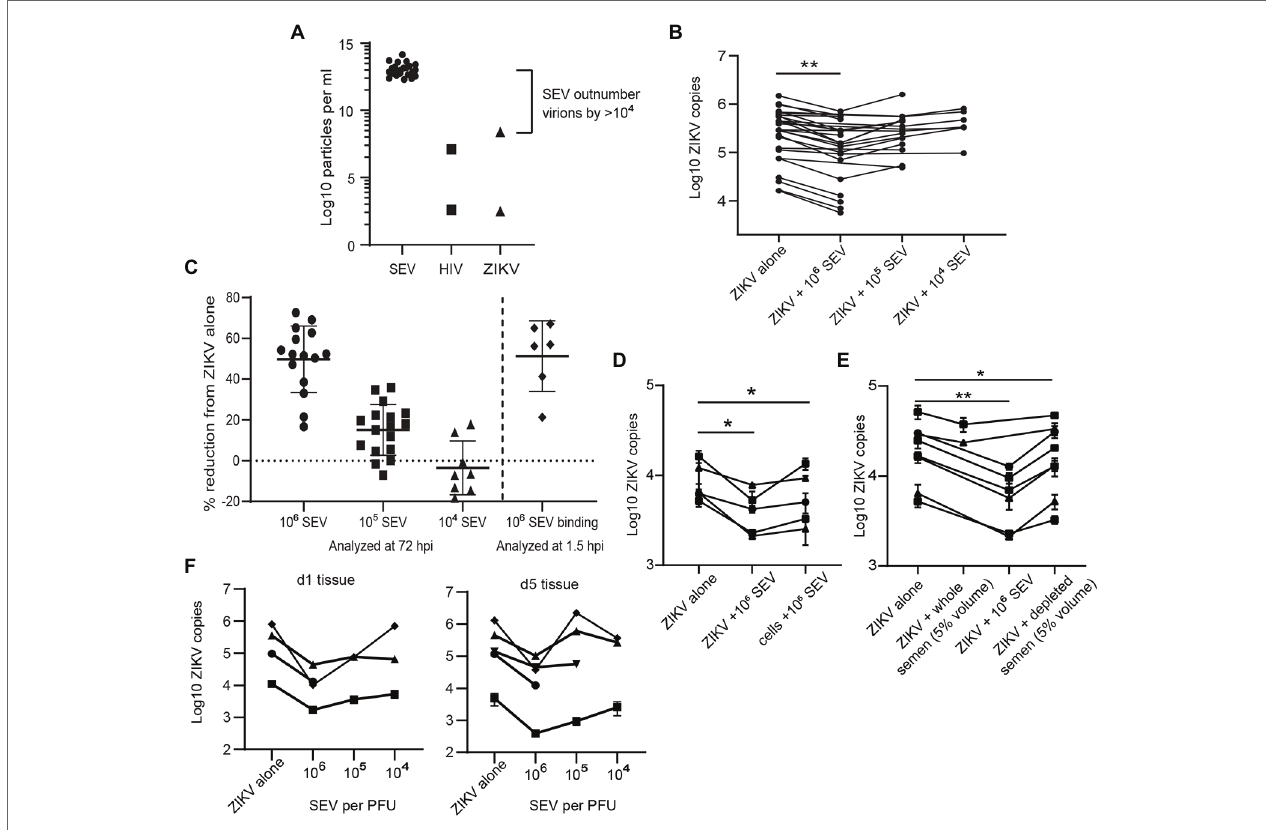
FIGURE 3 | Seminal extracellular vesicles inhibit ZIKV binding and infection. (A) Comparison of the average yield of SEV per ml of semen ( n = 23 donors) and reported viral RNA loads for ZIKV (Mead et al., 2018) and HIV (Gupta et al., 1997) viruses. Points for HIV and ZIKV represent high and low estimates of viral loads in semen. (B) ZIKV was incubated with 10 6 , 10 5 , or 10 4 SEV per PFU of virus for 1 h at 37 ° prior to infection of genital epithelial cells at a MOI of 1. After 1.5 h at 37 ° , the inoculum was removed and cells were cultured for 72 h. Log copies of ZIKV RNA quantified by ddPCR and normalized to the housekeeper gene RPP30 are plotted, averaged over duplicate wells. Each line represents a different cell line. Decrease in ZIKV genomes in the 10 6 SEV condition is significant by mixed-effects analysis with Dunnett’s multiple comparisons test. ** p < 0.01. (C) Quantification of inhibition of infection at 72 and 1.5 h post-infection. For 72 hpi, data from B is plotted as percent reduction of ZIKV genome copy number, measured by ddPCR, compared to cells exposed to ZIKV alone. For “SEV binding,” genital epithelial cells simultaneously exposed to ZIKV and 10 6 SEV per PFU were lysed at 1.5 hpi. Each point is a separate cell line, and horizontal bars indicate means. ** p < 0.05. (D) Comparison of pre-incubation of either ZIKV or epithelial cells with SEV on viral infection. SEVs were pre-incubated with ZIKV (ratio:10 6 SEV per PFU) or with cells (ratio: 10 6 SEV per cell) for 1 h at 37 ° , then virus was added to cells for 1.5 h. Cells were washed and cell-associated ZIKV genomes were quantified by ddPCR. Each line represents the average of two technical replicates from different epithelial cell lines. Significance by one-way ANOVA with repeated measures, with Dunnett’s multiple comparisons test. * p < 0.05. (E) ZIKV was pre-incubated with whole semen containing the equivalent of 10 6 SEV per PFU (approximately 5% volume), 10 6 isolate SEV per PFU, or with 5% volume of SEV-depleted seminal plasma. Samples were added to cells for 1.5 h, then ZIKV genomes quantified by ddPCR. Each line represents the average of two technical replicates from different epithelial cell lines significance as in D . ** p < 0.01. (F) Ex-vivo vaginal tissues were infected overnight with 500,000 PFU of ZIKV alone, or ZIKV pre-incubated for 1 h at 37 ° with 10 6 , 10 5 , or 10 4 SEV per PFU of virus. Tissues were washed extensively and then lysed for RNA isolation and quantification of ZIKV genomes by ddPCR immediately (d1 following addition of virus) or were cultured for an additional 4 days prior to RNA isolation. Each symbol denotes the average of two wells, error bars are standard deviation, and each line is a different tissue